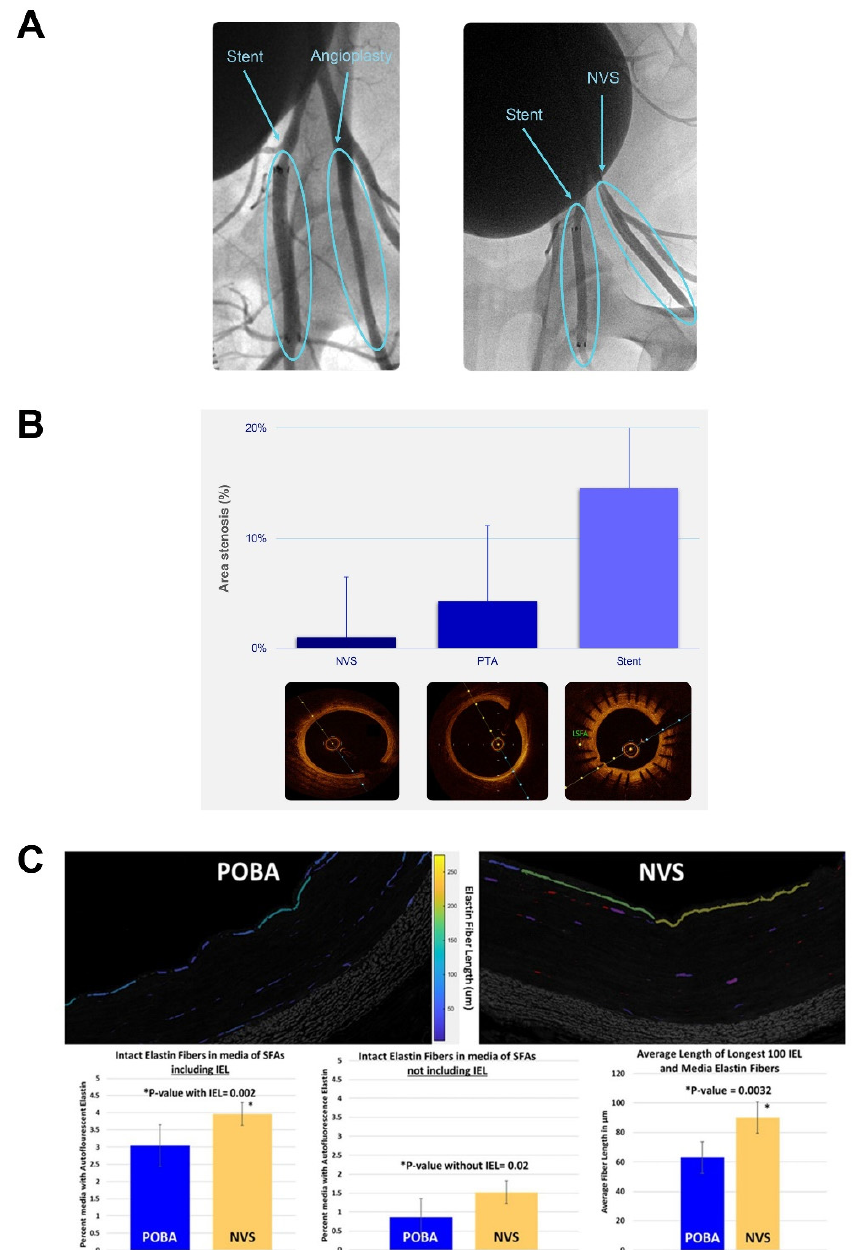
Figure 9. NVS treatment effect in hypercholesterolemic swine: ( A ) Angiographic images of stent- and POBA-treated vessels ( left panel) and stent- and NVS-treated vessels ( right panel). ( B ) Optical coherence tomography images of the NVS-scaffolded vessels in comparison with POBA and stenting. ( C ) Multiphoton images of arterial cross-sections after NVS and POBA treatment with quantitated elastin fiber amount and length in the vessel wall using MIPAR analysis.